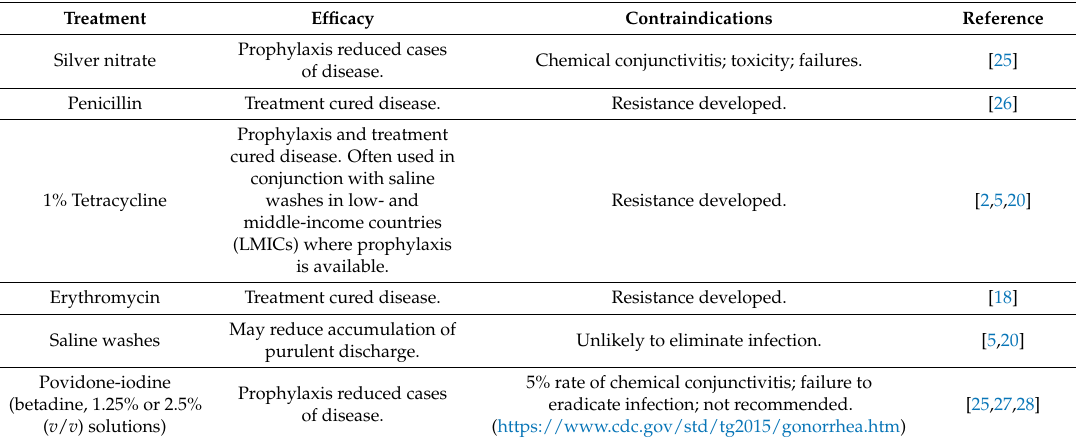
Table 1. Overview of topical treatments and prophylaxes for gonococcal ophthalmia